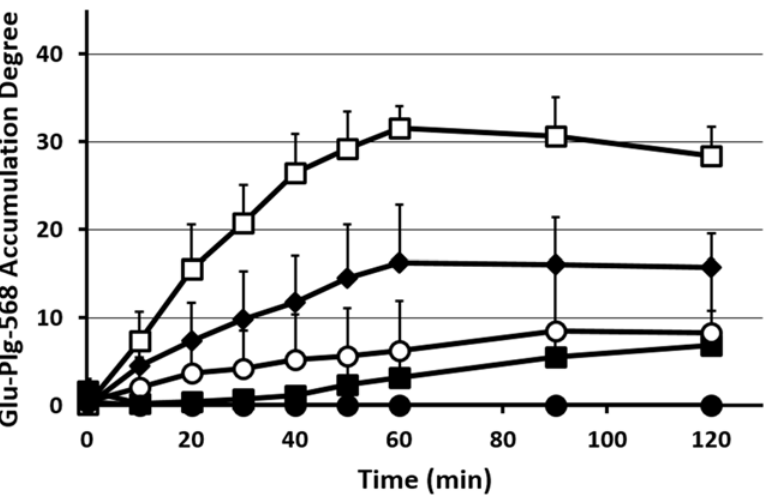
Fig 3. Changes in Glu-plg-568 accumulation in microthrombi after laser injury. The kinetics of Glu-plg- 568 accumulation are shown as an increase in the integrated fluorescence intensity of Glu-plg-568 per corresponding thrombus area in the same optical section 60 minutes after laser-induced thrombus formation. Reagents were EACA (closed squares, N = 5, 5 thrombi from 3 mice, p < 0.001), CPB (closed diamond, N = 5, 5 thrombi from 5 mice, p < 0.005) and aprotinin (open circles, N = 4, 4 thrombi from 2 mice, p < 0.001). Control experiments are shown as open squares (N = 5, 5 thrombi from 5 mice) and mini-plg-568 as closed circles (N = 4, 4 thrombi from 4 mice, p < 0.001). This assay was analyzed with repeated measures ANOVA. Each point represents the mean ± SD; N = number of